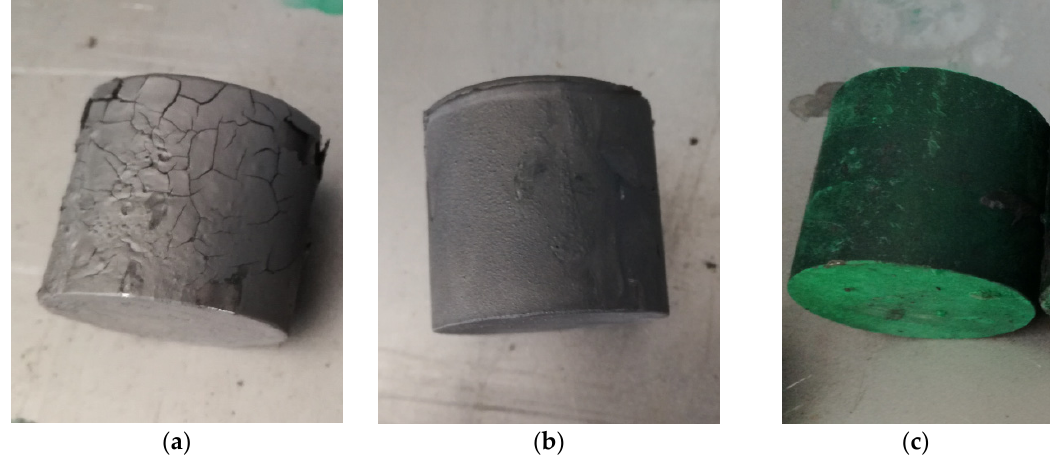
Figure 2. Pictures of the pre-forged parts after lubrication: ( a ) Berulit, ( b ) Bonderite and ( c ) Condursal.